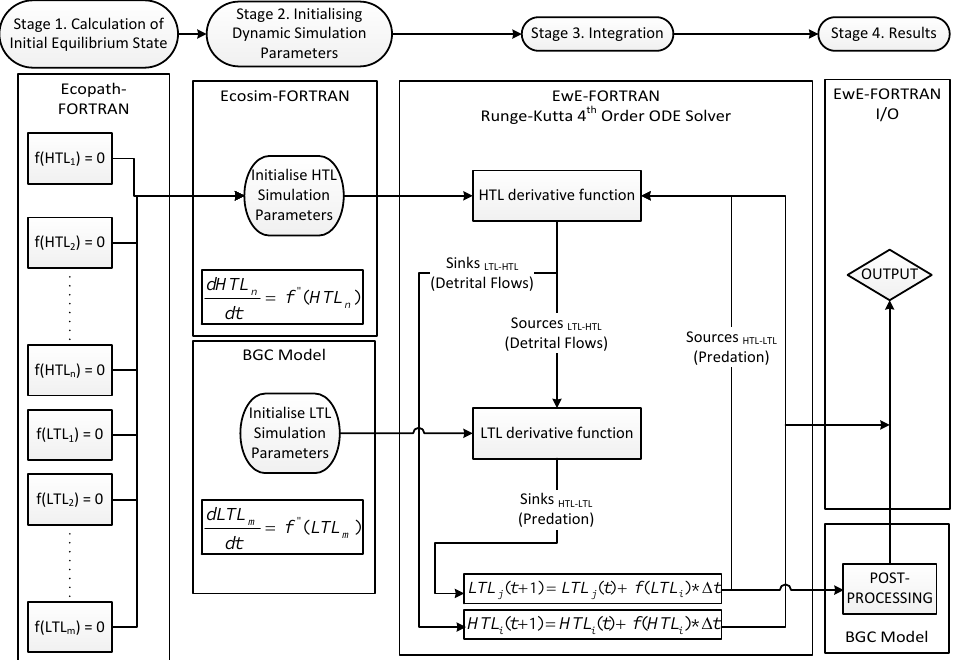
Figure 5. The technical overview of the coupling scheme. ODE stands for “ordinary differential equation”, I/O stands for “input/output”, and BGC stands for “biogeochemical model” used in the present